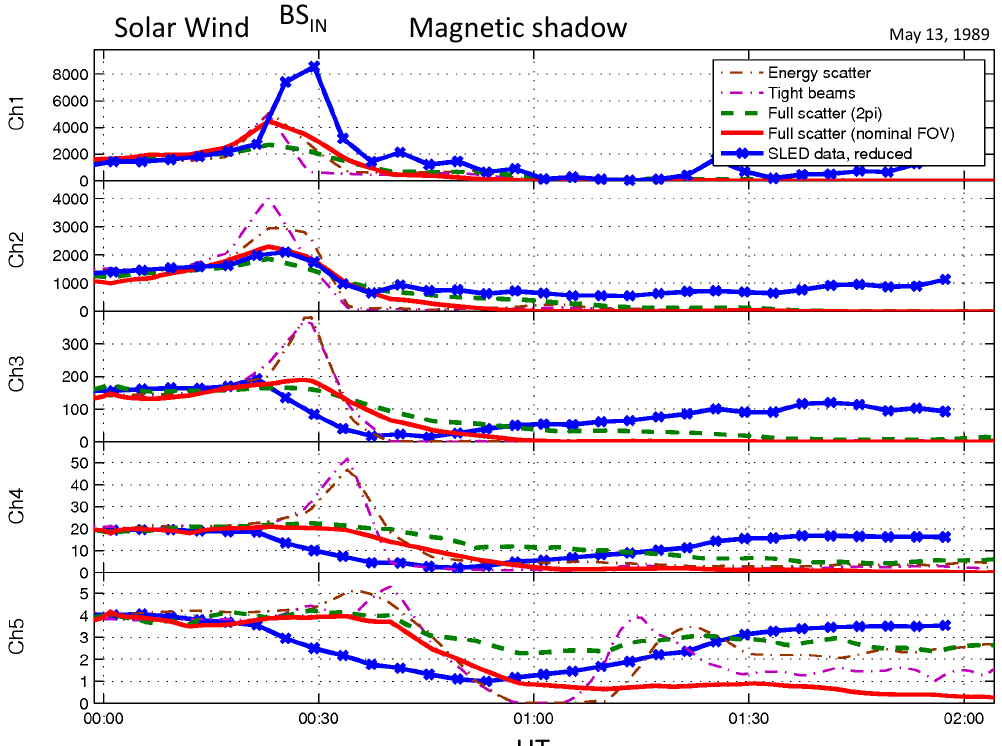
Fig. 9. Comparison of the simulated energetic proton fluxes and the particle fluxes measured by the SLED/Phobos-2 instrument along the circular orbit of Phobos-2 on 13 May 1989. The SLED ion data come from Telescope 1, from which the electrons were removed using the method described in the Appendix. The five panels display the normalized particle fluxes in five SLED energy channels. The plots show derived fluxes based on three different velocity distribution models: the beam, the energy scattered, and the fully scattered models (see Fig. 3 for details). Two “fully scattered” fluxes are shown in cases where the particle fluxes were collected from 2 π space (green solid line) and when the fluxes were collected from the field-of-view (FoV) of the SLED telescopes, looking toward the nominal spiral angle of 55 ◦ at Mars. The fully scattered model results in the best agreement with the data. For comparison, see Fig. 5 for contemporaneously measured and for simulated magnetic